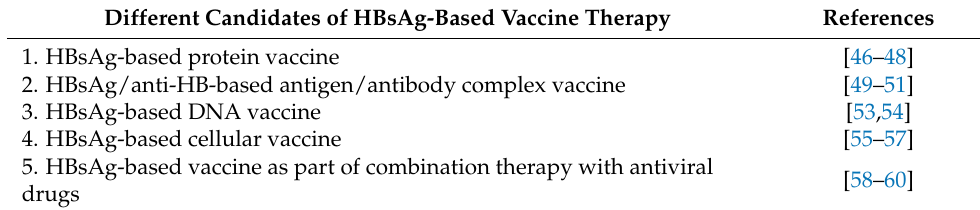
Table 3. Different forms of HBsAg-based vaccine therapies. Different Candidates of HBsAg-Based Vaccine